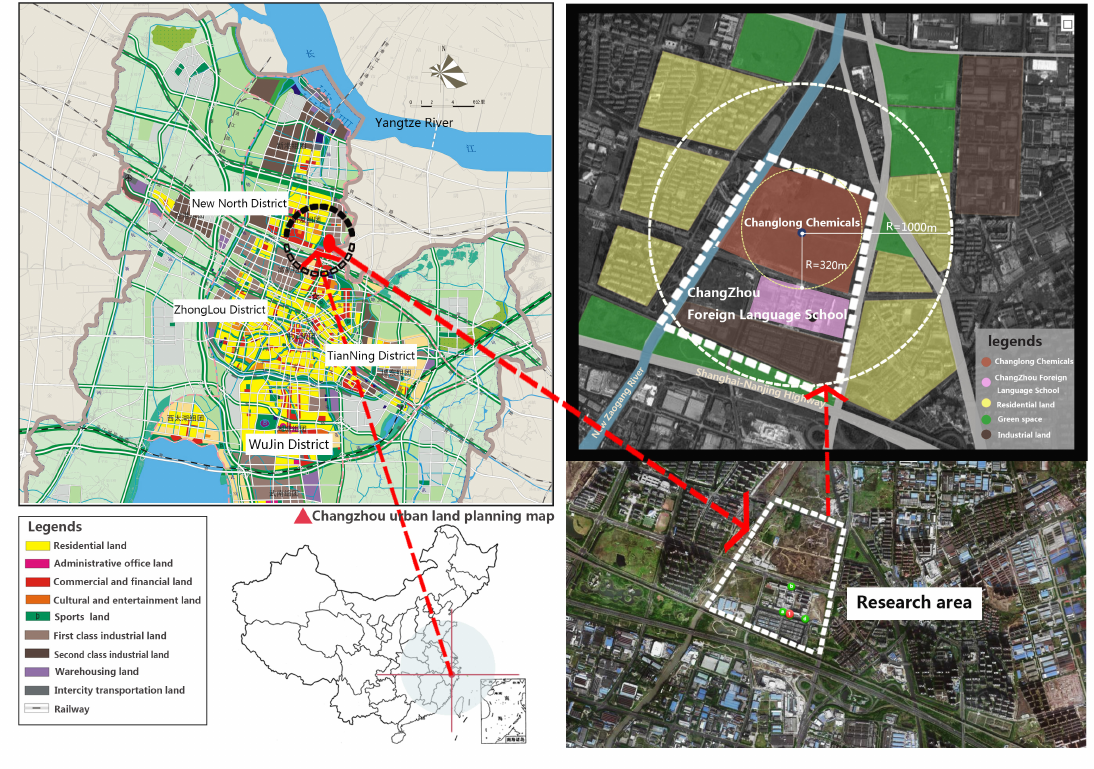
Figure 6. Location of the research target (adapted from